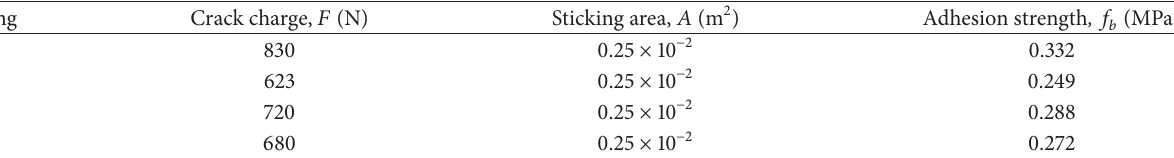
Table 3: Adhesion strength of coatings.